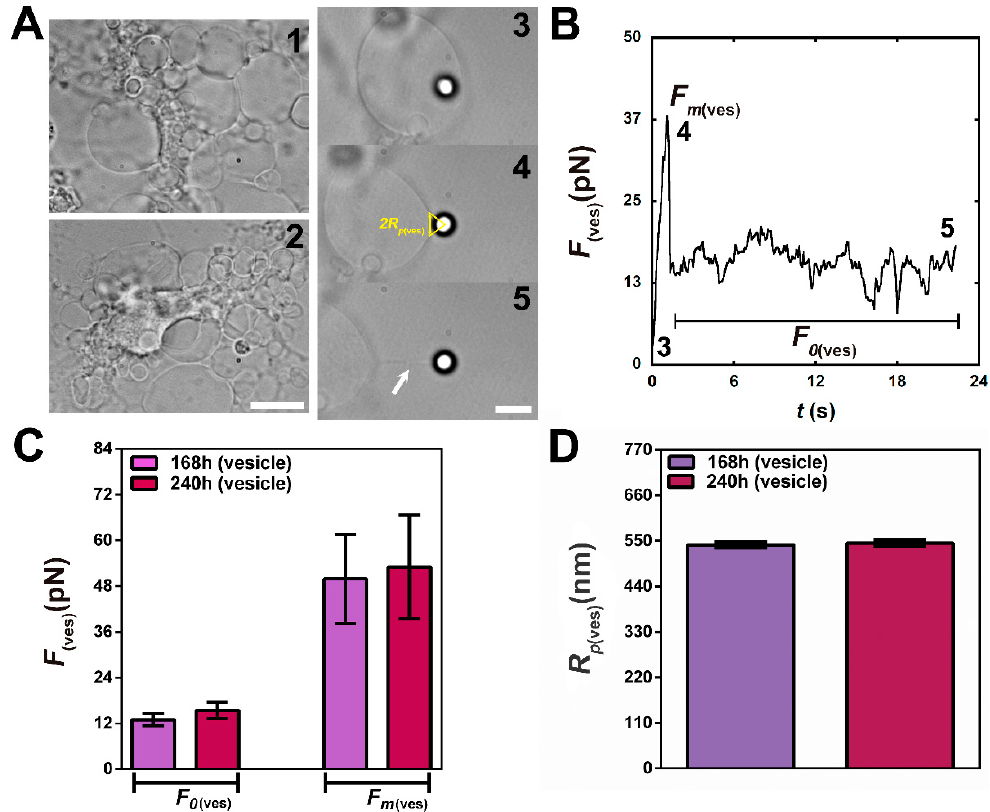
Figure 6. Tether extraction experiments and patch radius measurements for vesicles stemming from oligodendrocyte cell surfaces. ( A ) Typical bright field images of oligodendrocytes at 168 h (Image 1) and 240 h (Image 2), showing several vesicles along their surfaces. (Images 3–5) Selection of images of a typical tether extraction experiment from the surface of a vesicle. (Image 3) Initial moment, bead is being pressed against the vesicle with the optical trap, (Image 4) moment when the force reaches the maximum value – schematics indicating how R p ( ves ) is obtained – and, (Image 5) membrane tether already formed, indicated as a white arrow. Scale bar for Images 1 and 2 is 10 µ m and for Images 3, 4 and 5 is 5 µ m. ( B ) Force curve of a tether extracted from a vesicle. Numbers 3, 4, and 5 in the plot correspond to the images of the same numbers in A. F m ( ves ) means the maximum force before tether formation and F 0 ( ves ) means the steady-state tether force. ( C , D ) Plot of the mean values of F 0 ( ves ) and ( C ) and R p ( ves ) ( D ) for each experimental condition, as indicated by the plot legends. Standard errors were used as error bars in C and D. At least 20 di ff erent vesicles were analyzed for each situation. Altogether, the results confirm that NPCs are able to di ff erentiate into